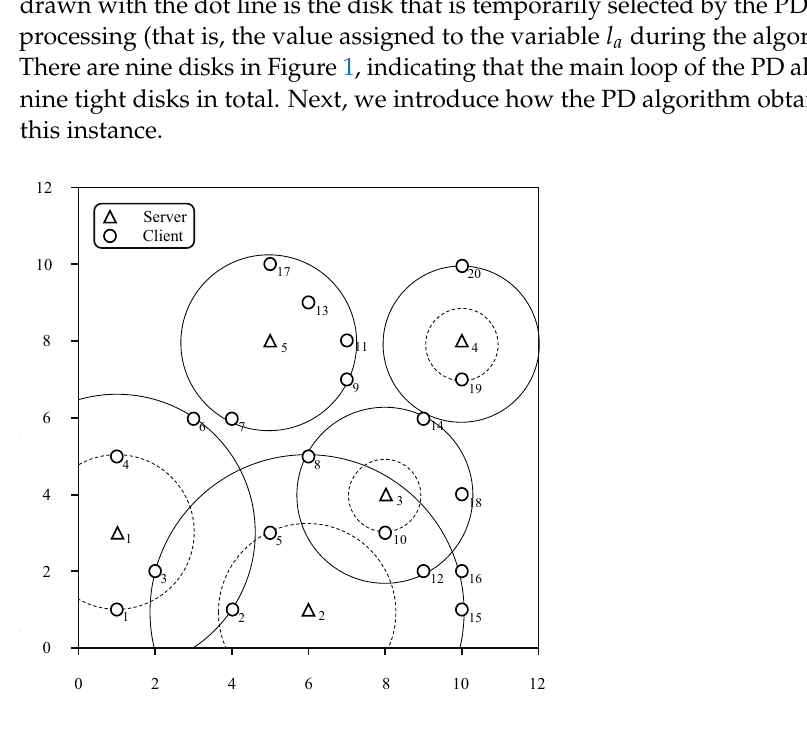
Figure 1. Total power of the PD algorithm with different numbers of servers and values of K